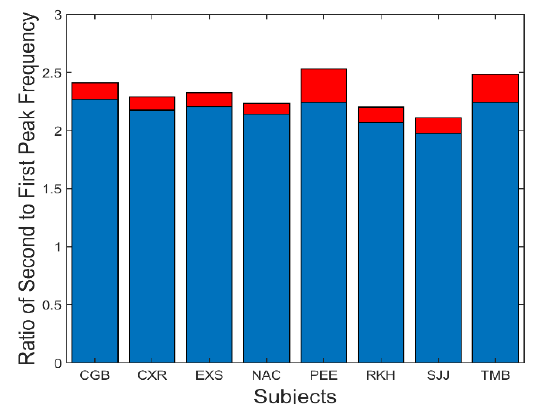
Figure 8: Slow component oscillations showed harmonic components with frequencies slightly more than twice that of the fundamental frequency. Mean is plotted in blue and standard deviations is plotted in red.